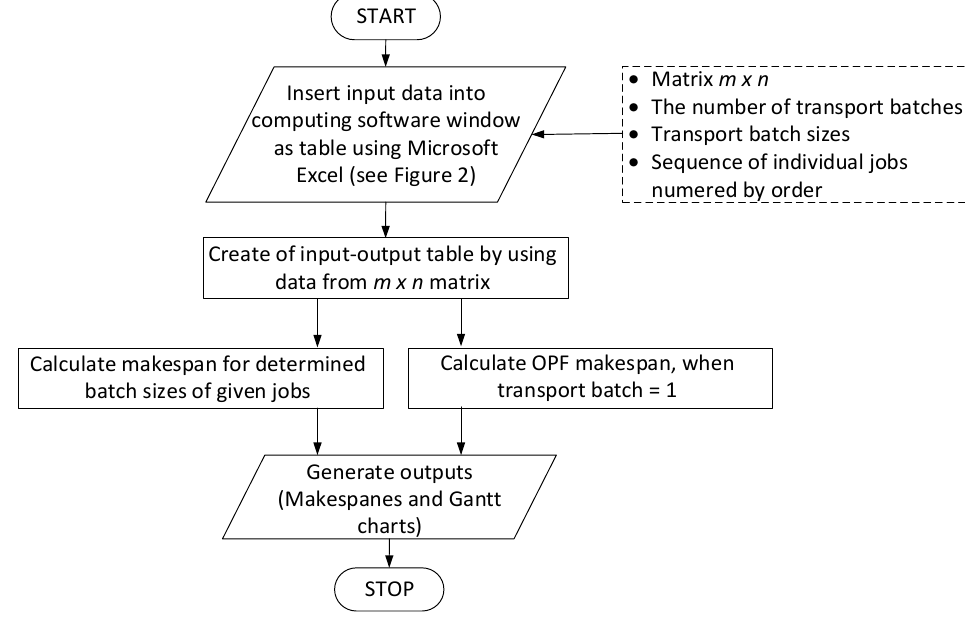
Figure 3. Software flowcharts with acquired